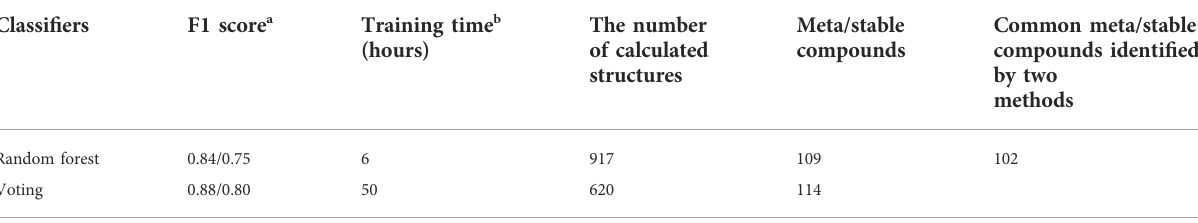
TABLE 5 Comparison between the voting and random forest classi fi ers in model training time, the number of calculated and meta/stable A-mixed oxyhydrides. Classi fi